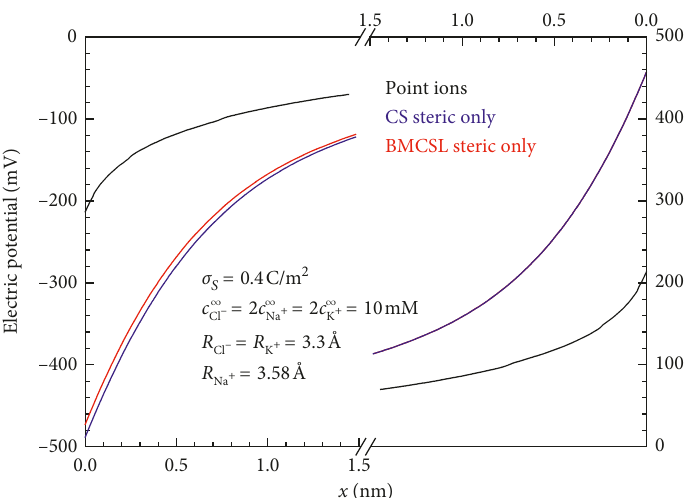
Figure 5: Electric potential profiles in the diffuse electric double layers near negative (left) and positive (right) interfaces, calculated using the CS and BMCSL steric interaction only models and mixed aqueous NaCl and KCl solutions with the indicated parameters.